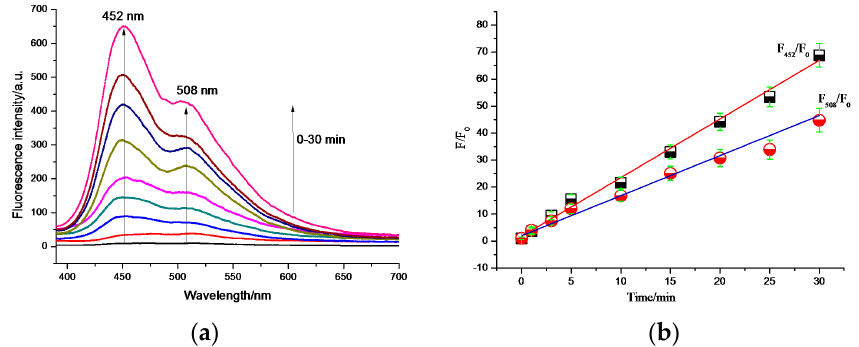
Figure 2. ( a , b ) Time-dependent fluorescent spectral changes of PHBT under UV irradiation (0–30 min) at room temperature, PHBT dissolved in PBS buffer (10 mM, pH 7.4, aqueous 20% bovine serum solution) to form 10 µM testing solution with excitation λ = 365 nm.